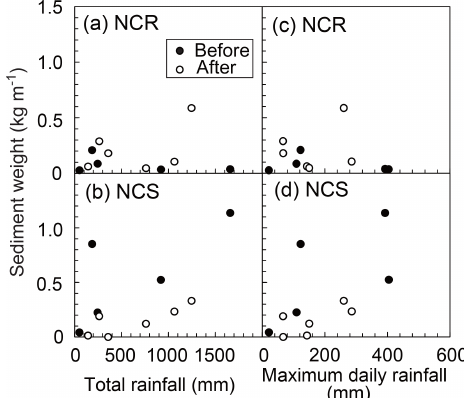
Figure 14. Comparison between rainfall factors and sediment weight captured by sediment traps during rainfall seasons in the non-harvested area. (a) Total rainfall and sediment weight at plot NCR. (b) Total rainfall and sediment weight at plot NCS. (c) Maxi- mum daily rainfall and sediment weight at plot NCR. (d) Maximum daily rainfall and sediment weight at plot NCS.